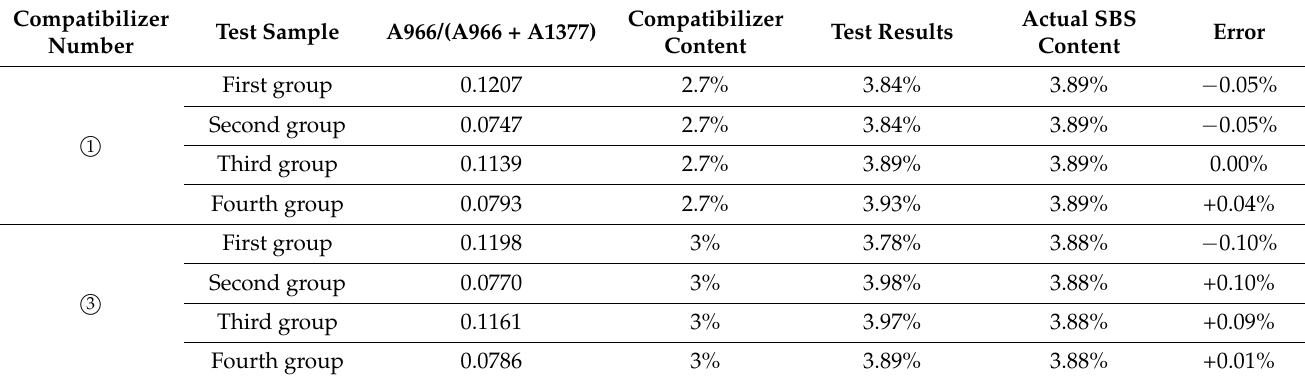
Table 4. Test results of SBS-modified asphalt with compatibilizer.